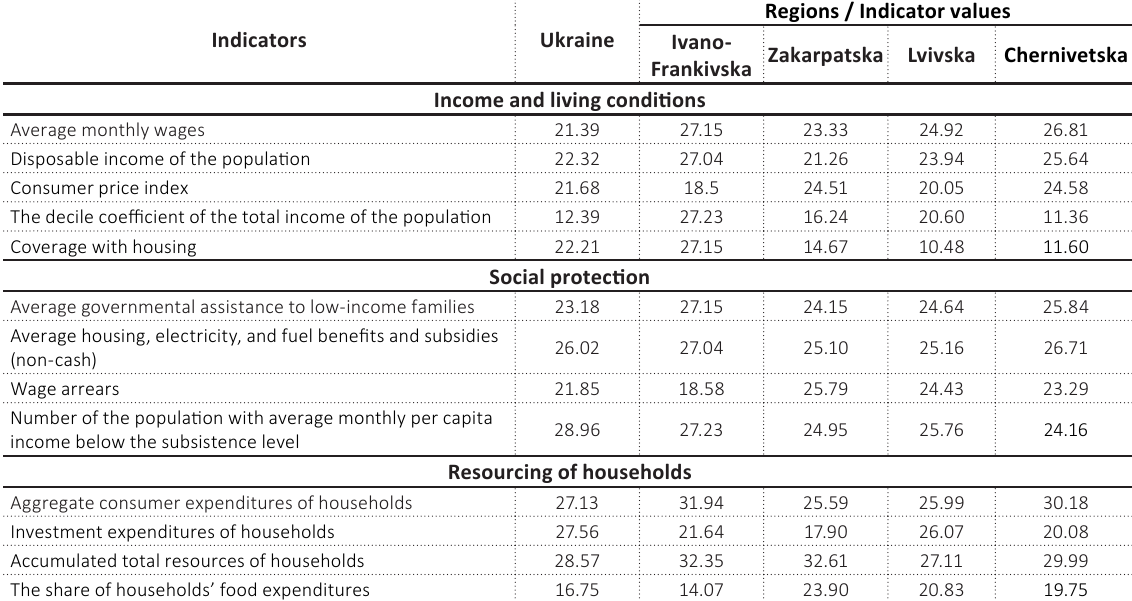
Table 2. Coefficients of weight significance of households’ financial wellbeing indicators in Ukraine and the oblasts of the Carpathian region, 2010–2019,